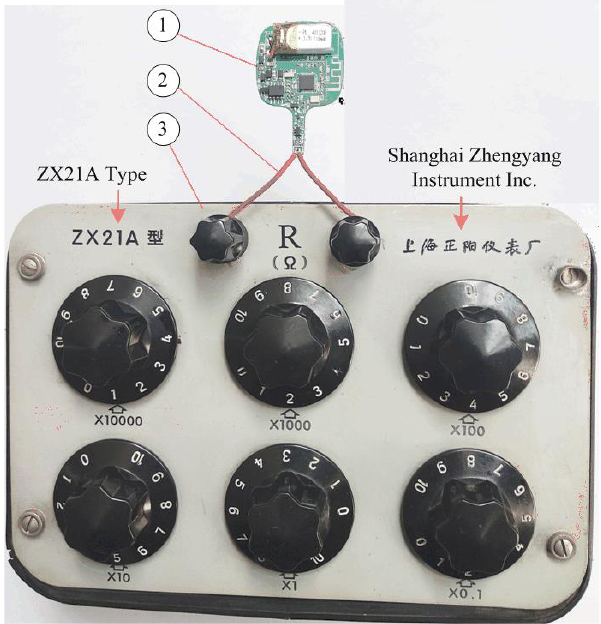
Figure 14. Experimental set-up for smart thermometer testing: (1) the developed smart thermometer PCB, (2) leading wires, and (3) a DC resistor device.